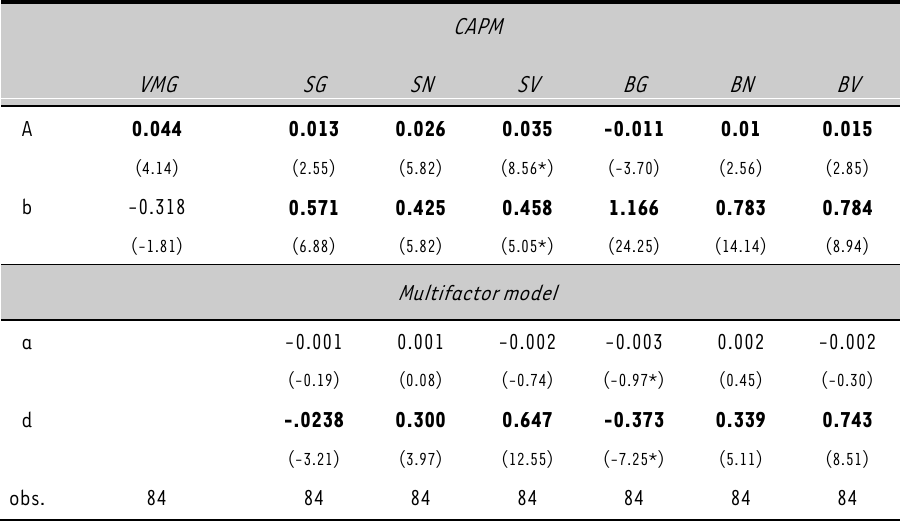
TABLE 2: CAPM and Multifactor model regression results, July 2000 to June 2007 (84 month)